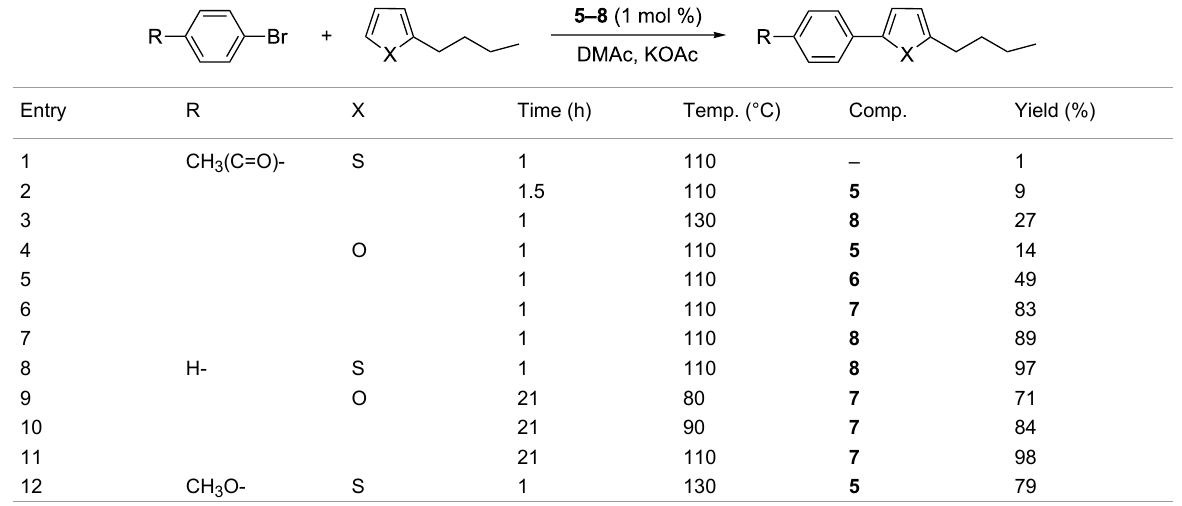
Table 1: PEPPSI Pd–NHC catalyzed direct intermolecular arylation of heteroaryl derivatives with various aryl bromides a,b .